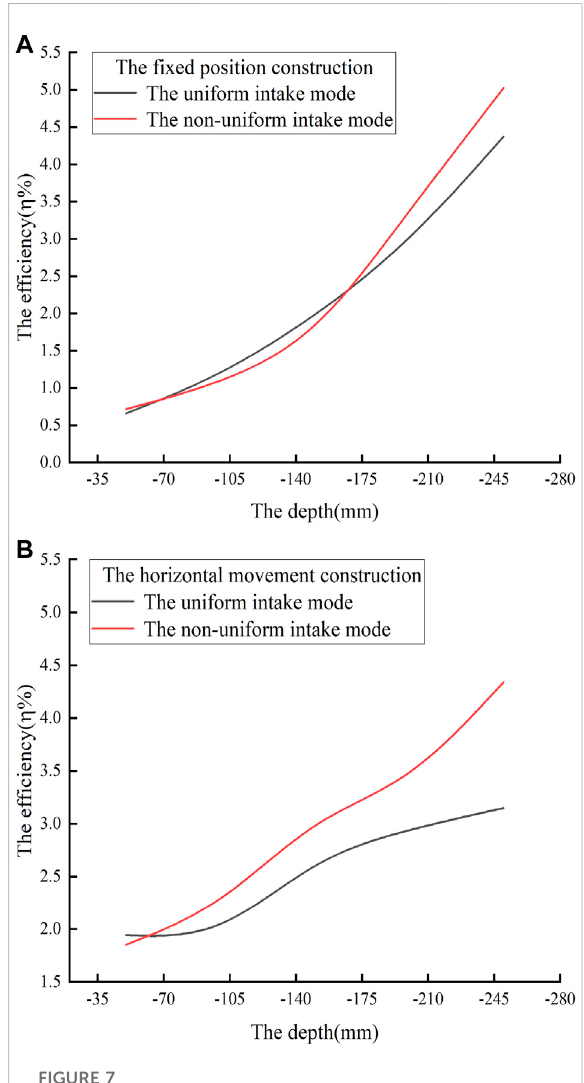
FIGURE 7 Variation of the air-lifting pump ef fi ciency with sand depth under different intake modes. (A) The fi xed position construction method. (B) The horizontal movement construction